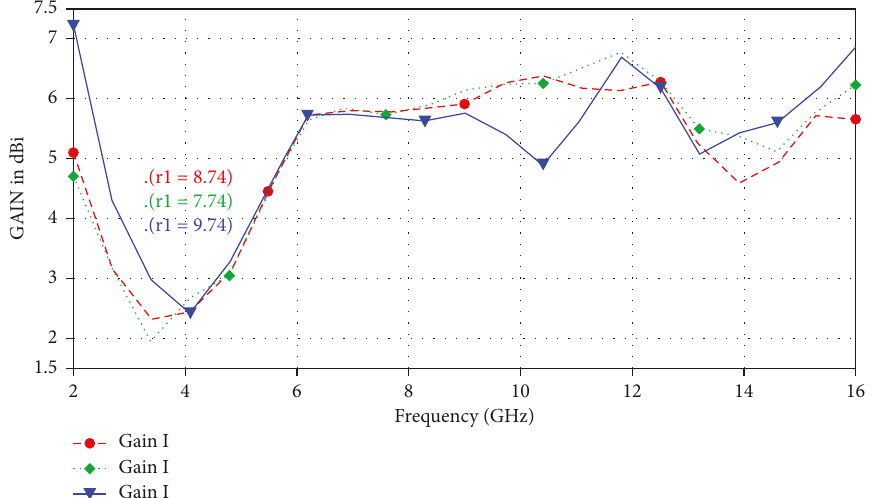
Figure 11: Gain vs. frequency plot.